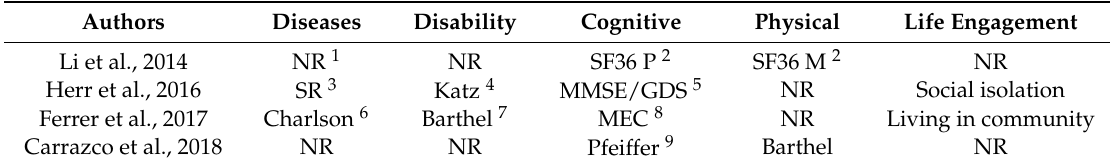
Table 2. Comparison of operationalization of successful aging measures by